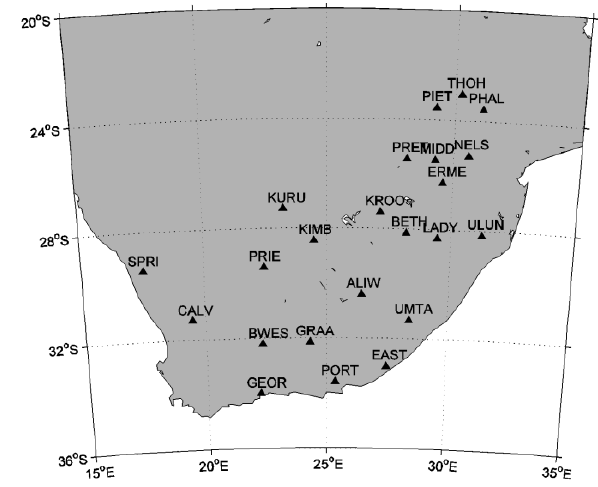
Figure 2 Distribution of TrigNet sites. Fig. 2. Distribution of TrigNet